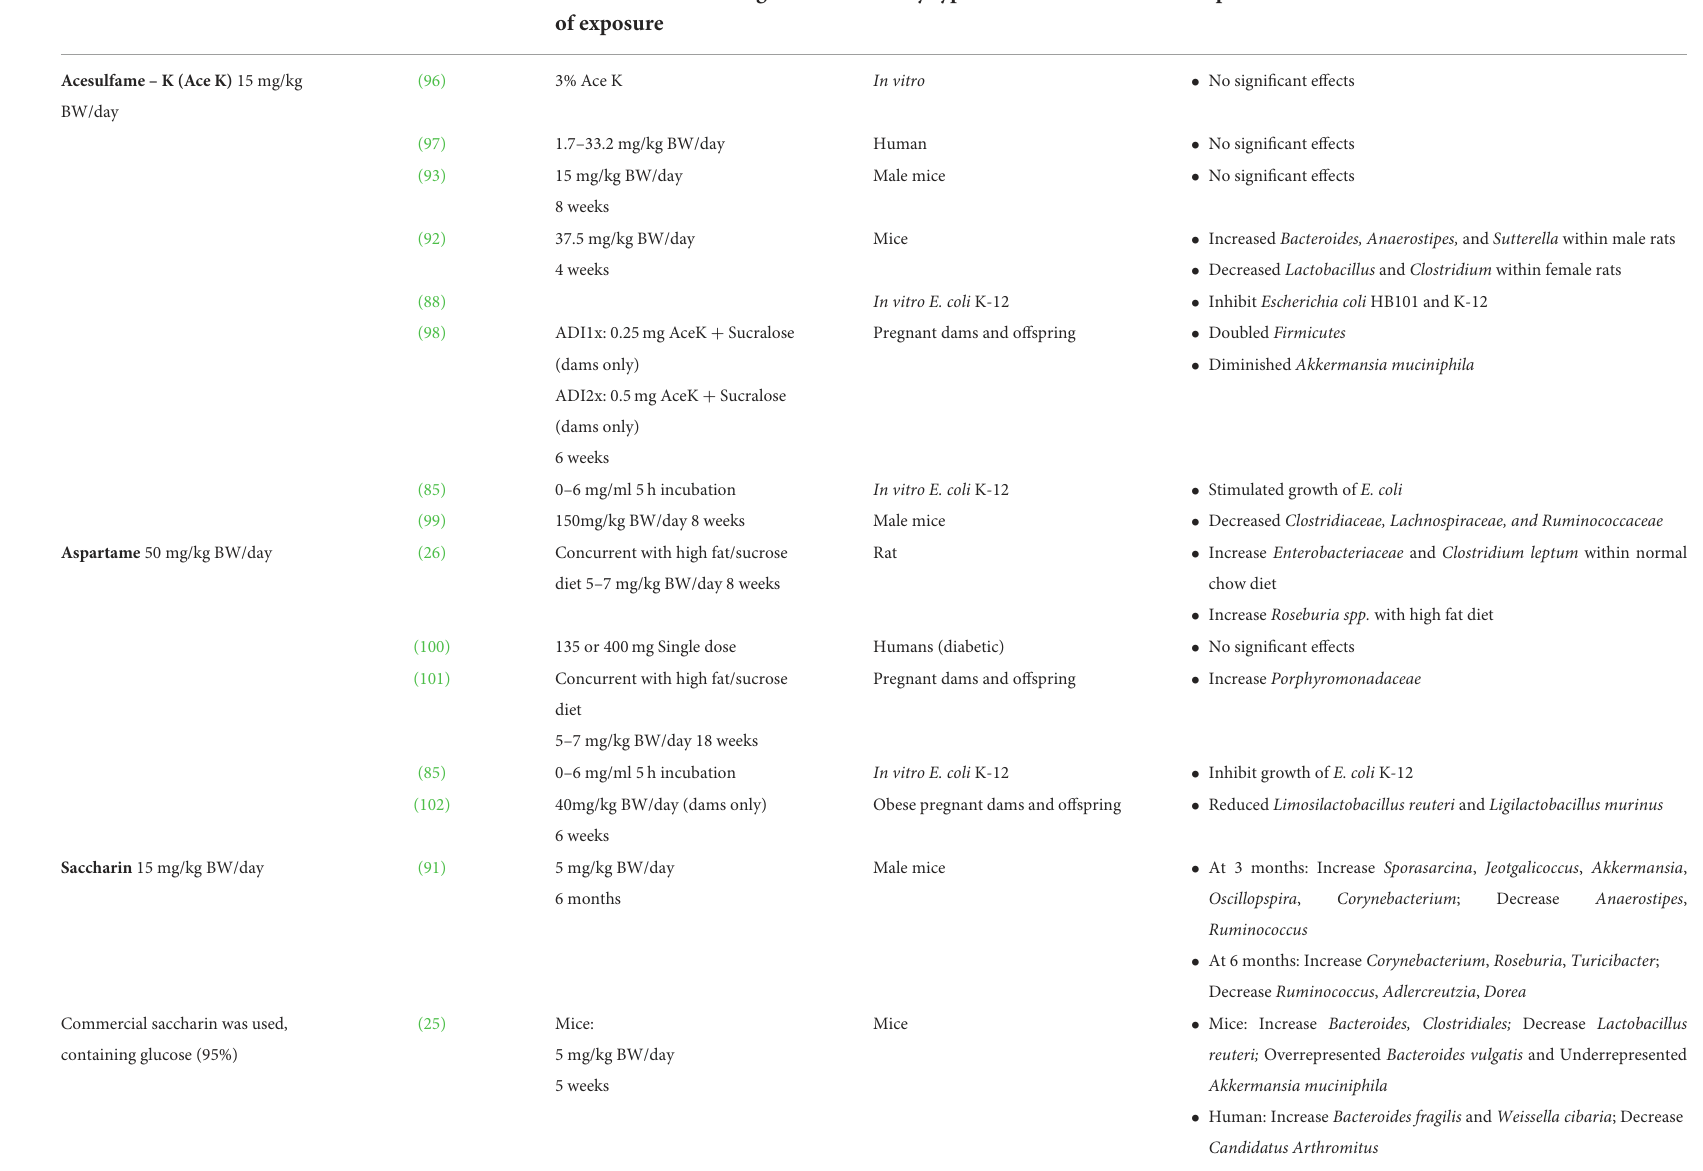
TABLE 2 Summary of changes to the gut microbiome in response to